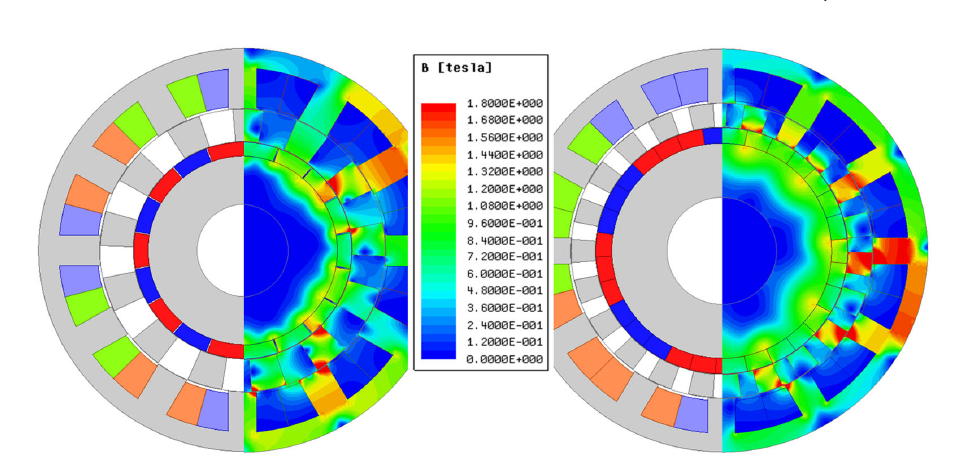
Figure 8. Design models and magnetic flux density distributions of 45kW ‐ class MG ‐ PMSM with